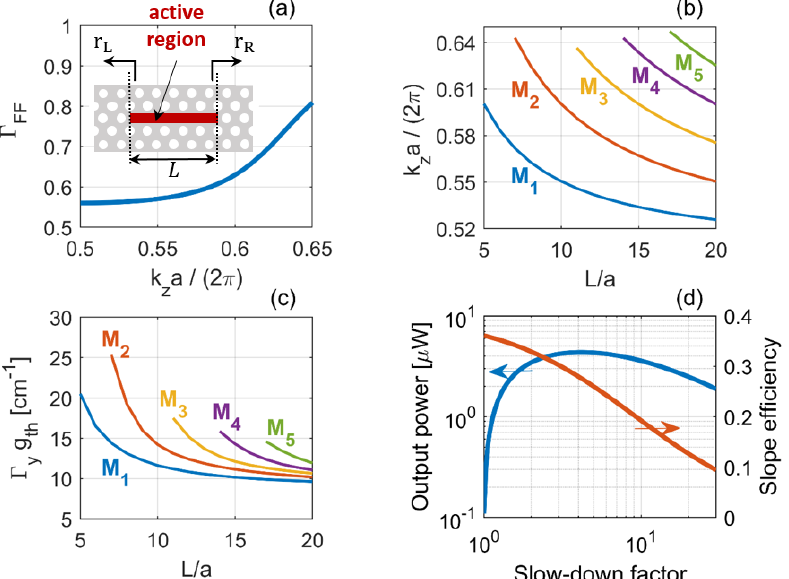
Figure 12. ( a ) Optical confinement factor Γ FF of a line-defect PhC laser with a buried heterostructure active region (inset). Γ FF was computed as if the active layers entirely filled the slab in the vertical ( y ) direction. The x -axis shows the wavenumber k z of the associated line-defect waveguide without active material. ( b ) Wavenumber and ( c ) modal gain at the lasing threshold of the various longitudinal modes versus cavity length. The modal gain only included the optical confinement factor Γ y , which was approximately independent of frequency. Γ y accounts for the optical confinement along the vertical direction within the active layers. ( d ) Output power ( left ) and slope efficiency ( right ) versus the slow-down factor. The cavity length was L = 5 a and the bias current was 50 µ A. Further details on the simulation parameters are provided within the